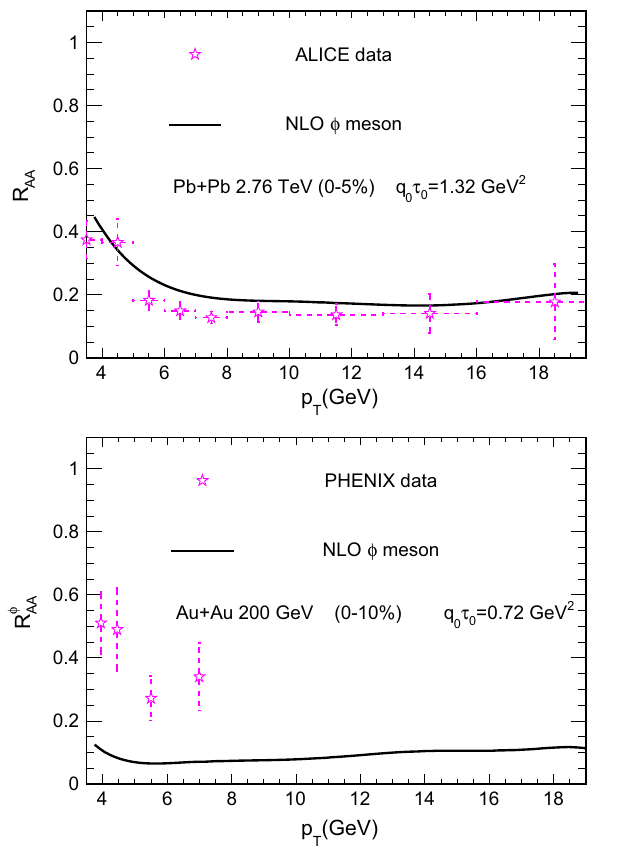
Fig. 4 Top The nuclear modification factor as a function of p T in Pb + Pb collisions at the LHC calculated at both LO and NLO accuracy, with ALICE data [17,18]. Bottom The nuclear modification factor as a function of p T in Au + Au collisions at the RHIC calculated at both LO and NLO accuracy, with PHENIX data [16]